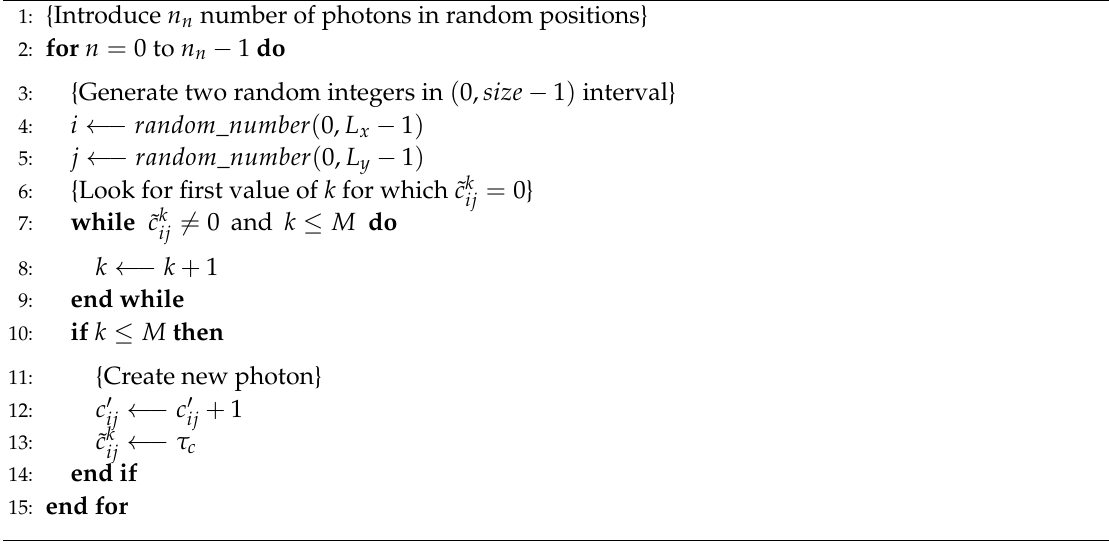
Algorithm 2 Pseudo code diagram for the implementation of the noise photons rule.